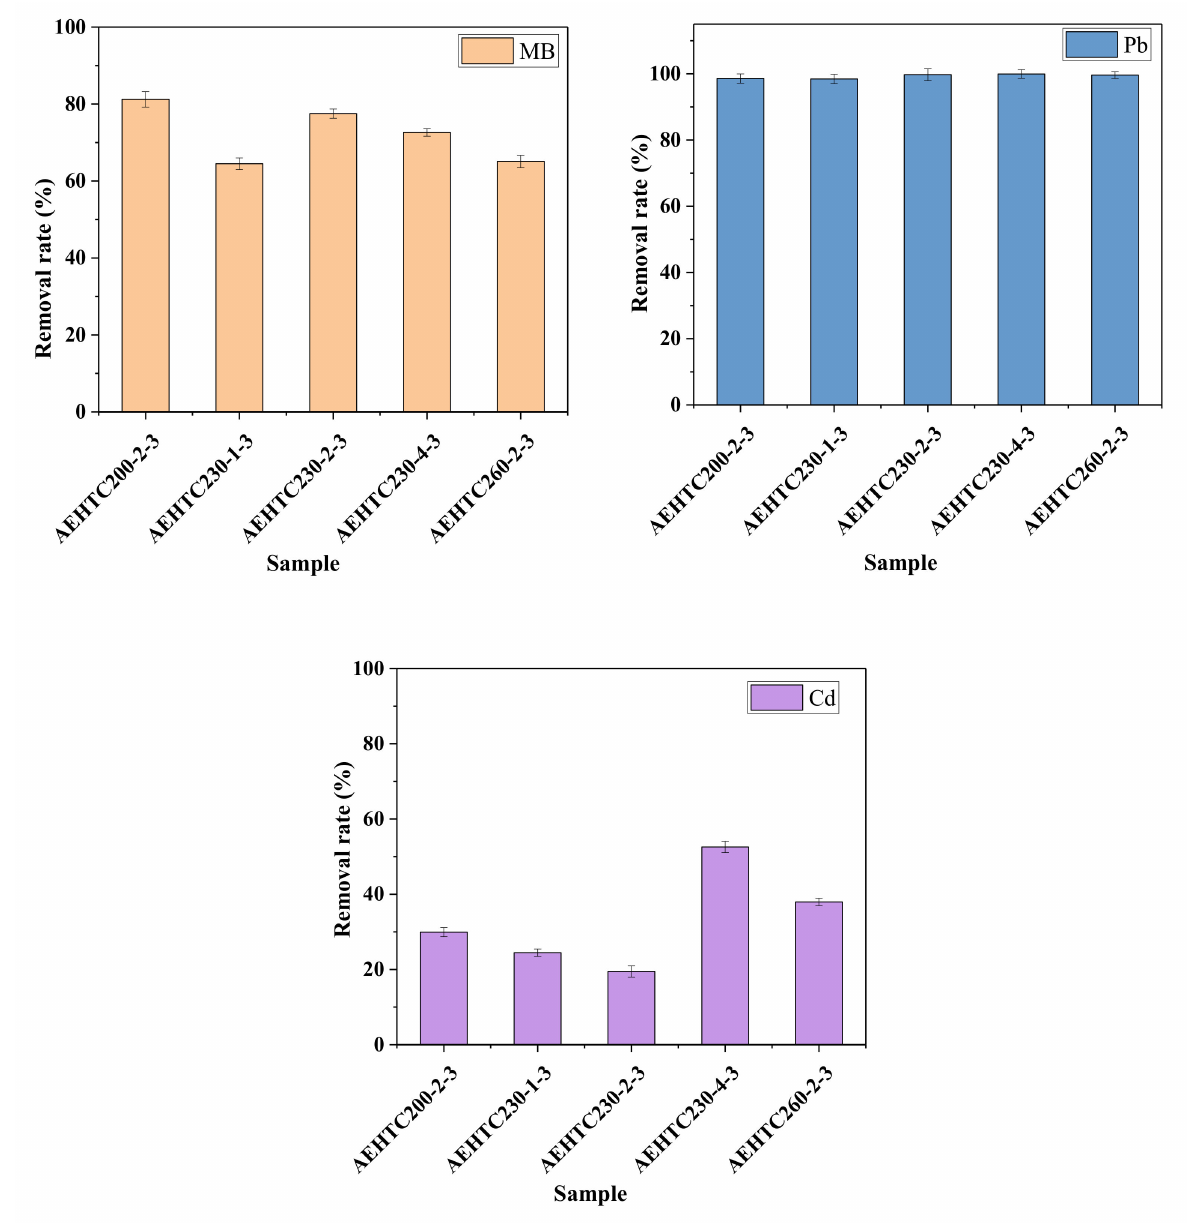
Figure 4. Effects of AE-CMIW hydrochar on the removal rates of MB, Pb 2+ , Cd 2+ in mixed